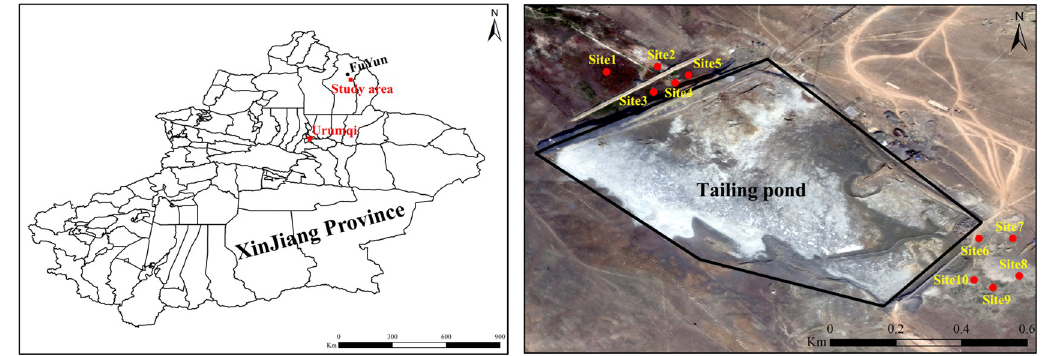
Fig 1. Location of the study area and distribution of the sample points. The map is based on the standard map number GS (2016) 1666 downloaded from the standard map service website of the National Bureau of Mapping Geographic Information, and the base map is not modified. https://earthexplorer.usgs.gov/.